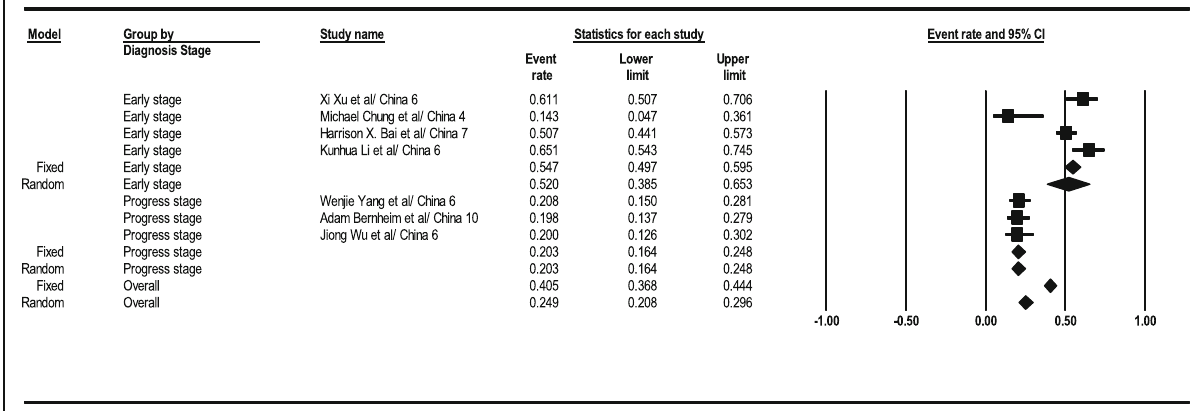
Fig. 8 Results of GGO in CT scan of patients